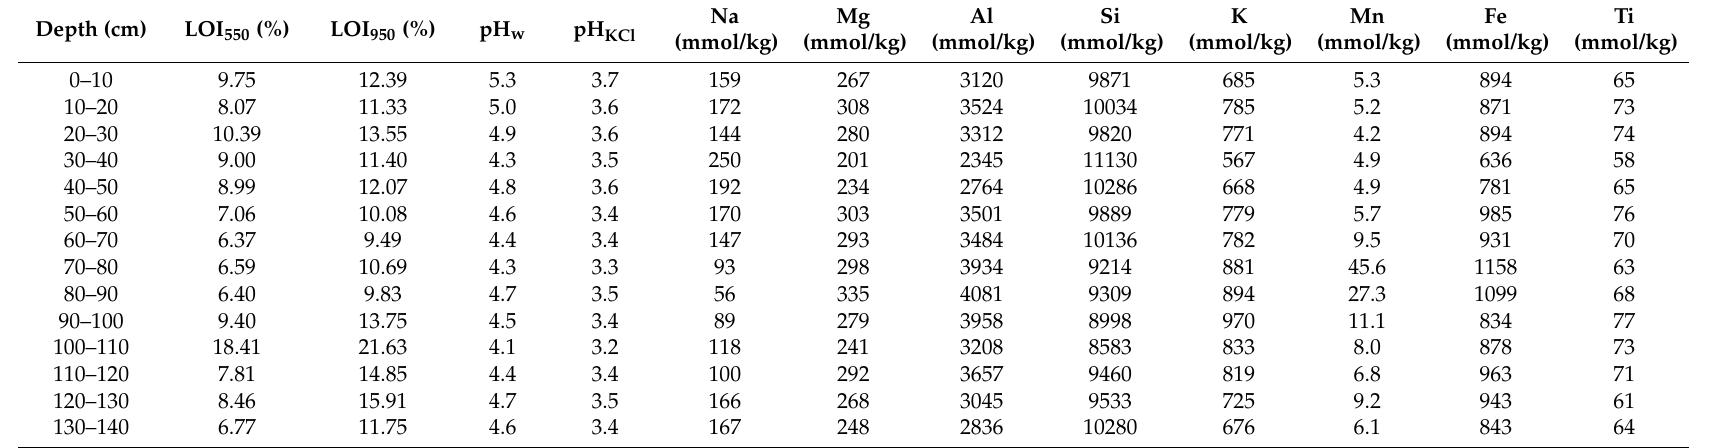
Table 1. Soil geochemical properties for core HR25-BY1. LOI: